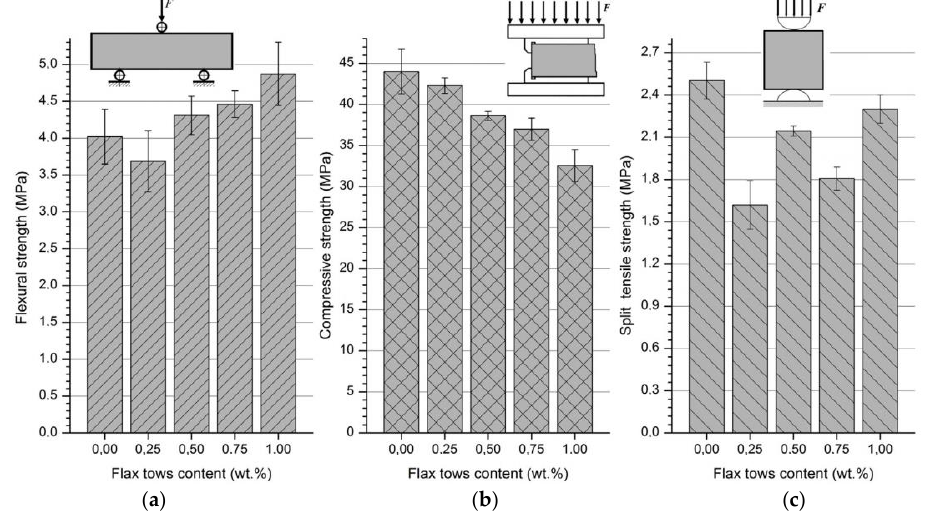
Figure 10. Effect of flax tows content on ( a ) flexural strength, ( b ) compressive strength, ( c ) split tensile strength of PFRGs [94].